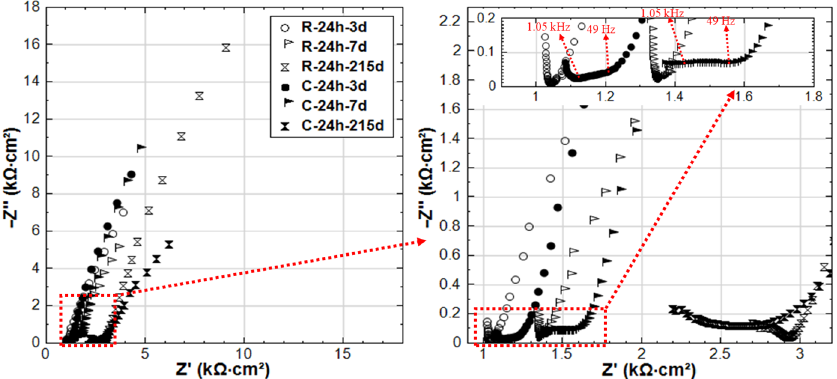
Figure 11. EIS responses overlay in Nyquist format of R-24h and C-24h (R-24h: Reference, 24h- cured specimens treated in water; C-24h: NaCl medium, 24h-cured specimens treated in 5% NaCl).